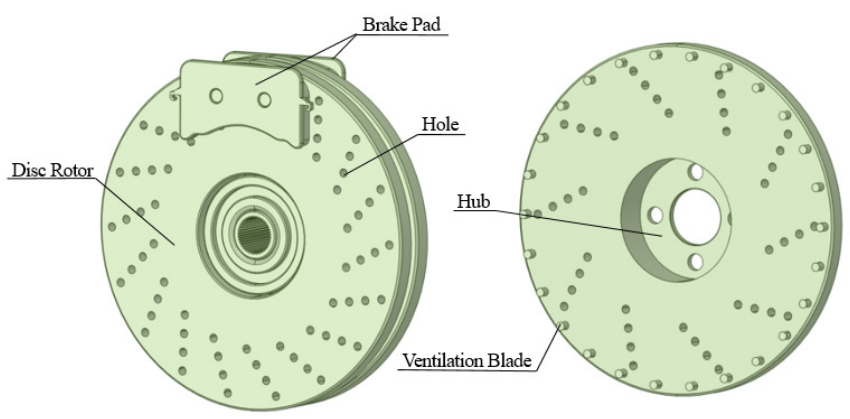
Figure 2. Ventilated brake disc model.